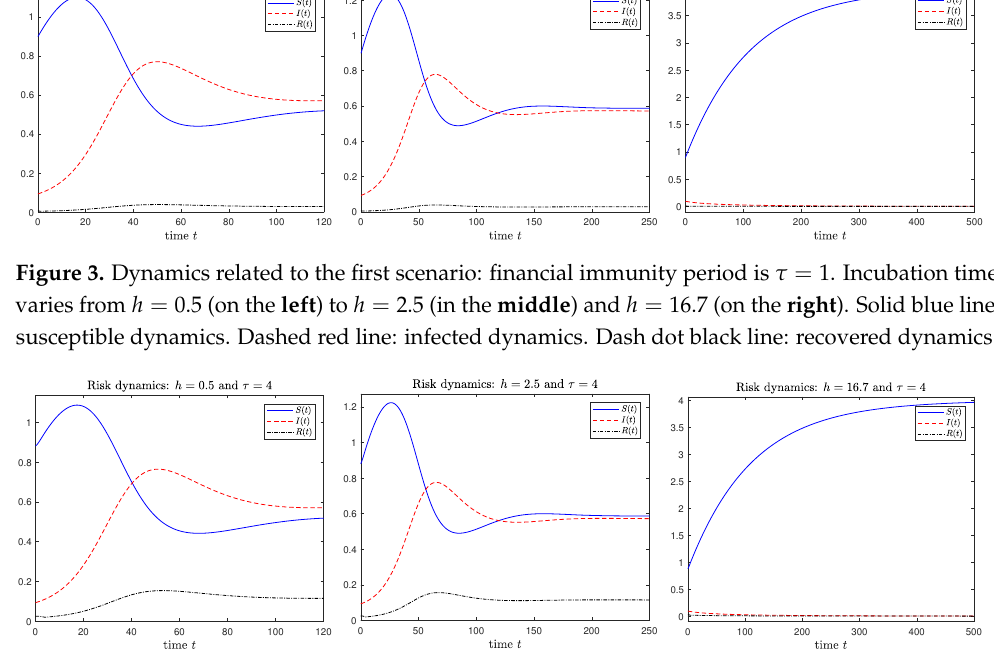
Figure 4. Dynamics related to the second scenario: financial immunity period is τ = 4, Incubation time varies from h = 0.5 (on the left ) to h = 2.5 (in the middle ) and h = 16.7 (on the right ). Dashed red line: infected dynamics. Dash dot black line: recovered